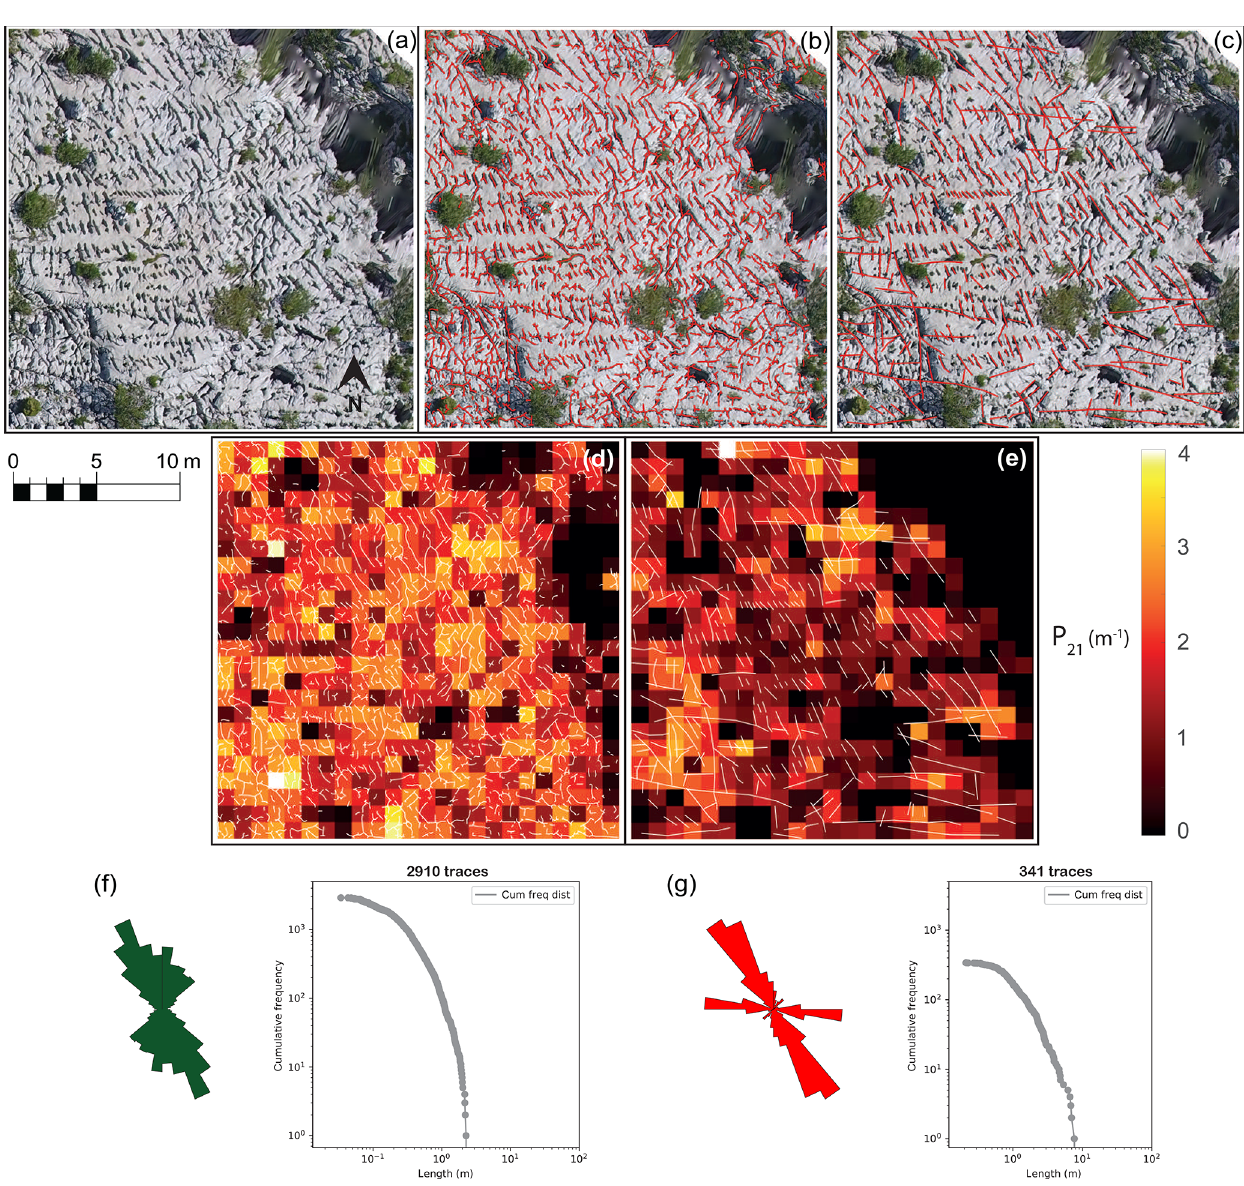
Figure 9. Comparison between automatic and manual interpretation on a tile from the Parmelan. (a) Tile from the Parmelan orthomosaic (Prabhakaran et al., 2019b) depicting intense fracturing with an organization along the NW–SE corridors. (b) Overlay of fractures traced using the automatic detection method. (c) Overlay of fractures manually traced for the tile at a zoom of 1 : 2000. (d) P 21 Fracture intensity for automatic extracted fractures. (e) P 21 Fracture intensity for manually extracted fractures. (f) Length-weighted rose plot and cumulative trace length frequency distribution for the automated result. (g) Length-weighted rose plot and cumulative trace length frequency distribution for the manual result. The Parmelan dataset (Prabhakaran et al., 2019b) is available under a CC-BY-NC-SA